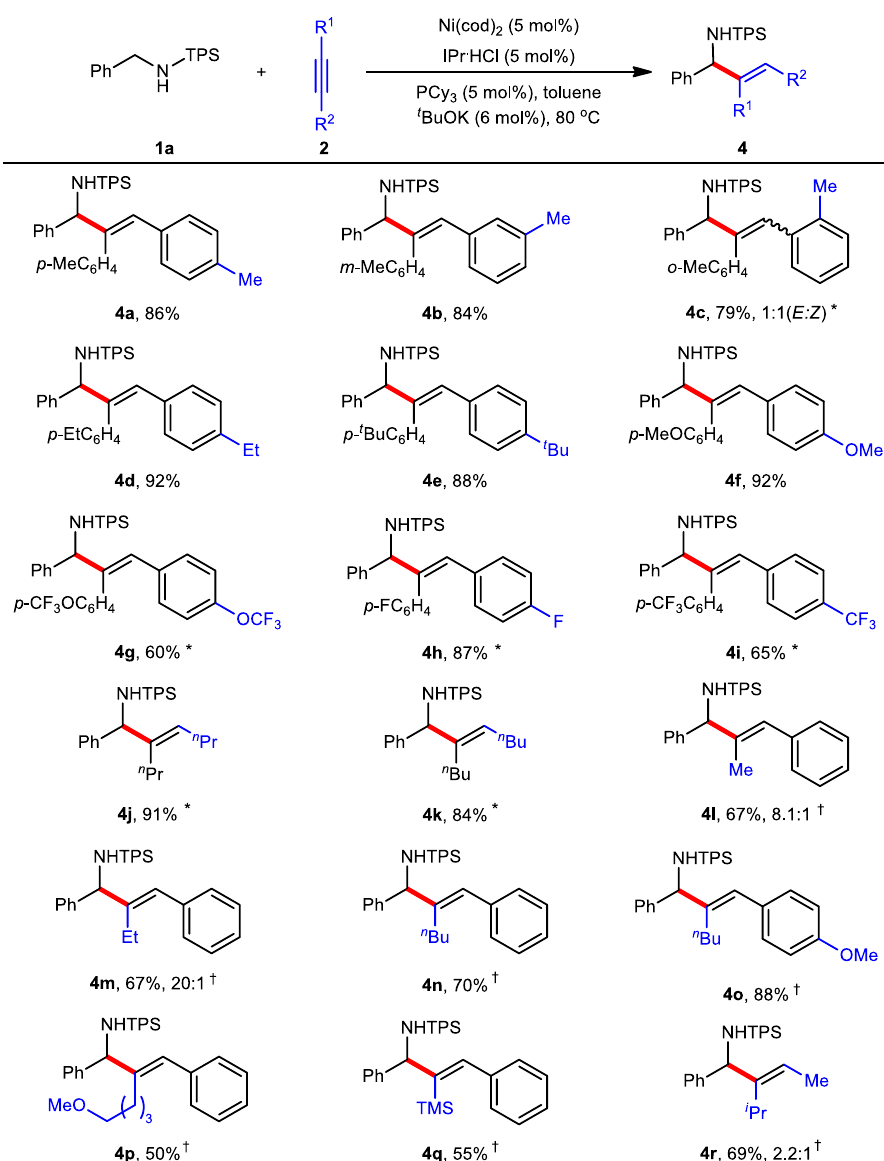
Fig. 4 Scope of alkynes. Reaction conditions: 1a (0.20 mmol), 2 (0.22 mmol), toluene (2.0 mL) under N 2 for 1 − 12 h; yield of isolated products. * 110 °C. † Ni (cod) 2 (10 mol%), IPr·HCl (10 mol%), PCy 3 (10 mol%), t BuOK (12 mol%) at 110 °C and regioisomer ratio. TMS =